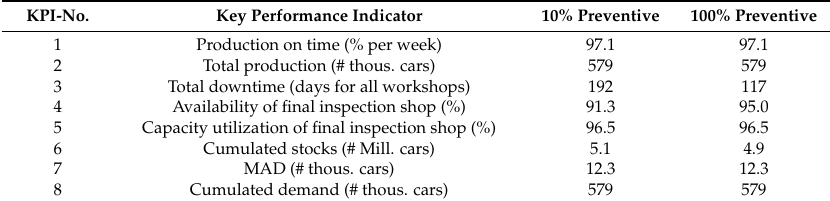
Table 7. Case study